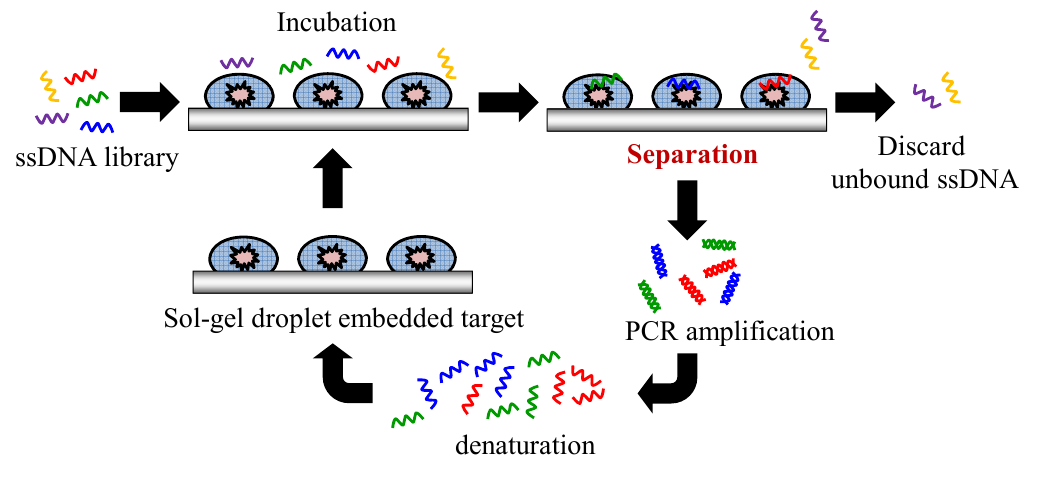
Figure 2. Schematic illustration of the SELEX processes in sol-gel microfluidic chips. A library of ssDNA is incubated with sol-gel arrays of proteins in a microfluidic system for efficient selection of ssDNA aptamers against target molecules. The sol-gel microfluidic chips greatly improved selection efficiency, reducing the number of selection cycles needed to produce high affinity